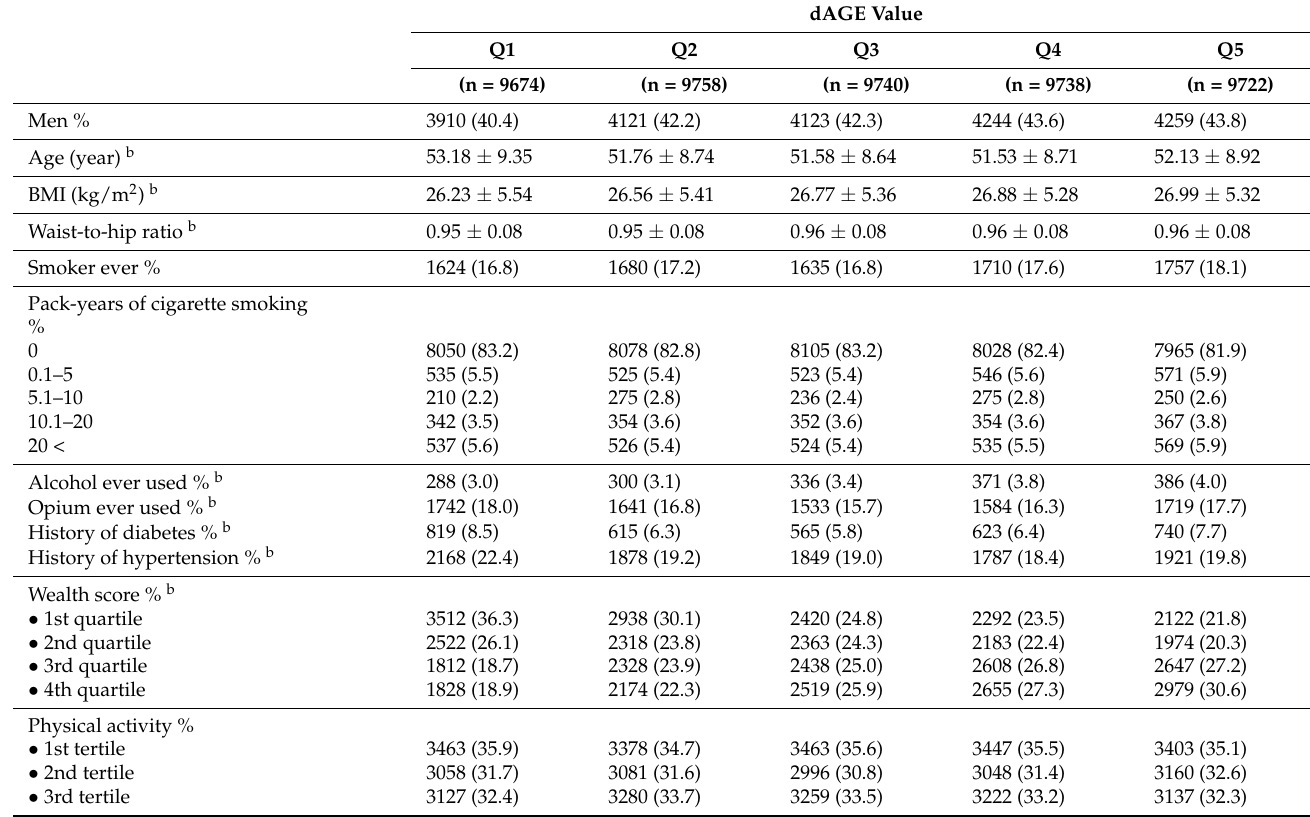
Table 1. Baseline characteristics of participants according to the quintiles of dAGE a